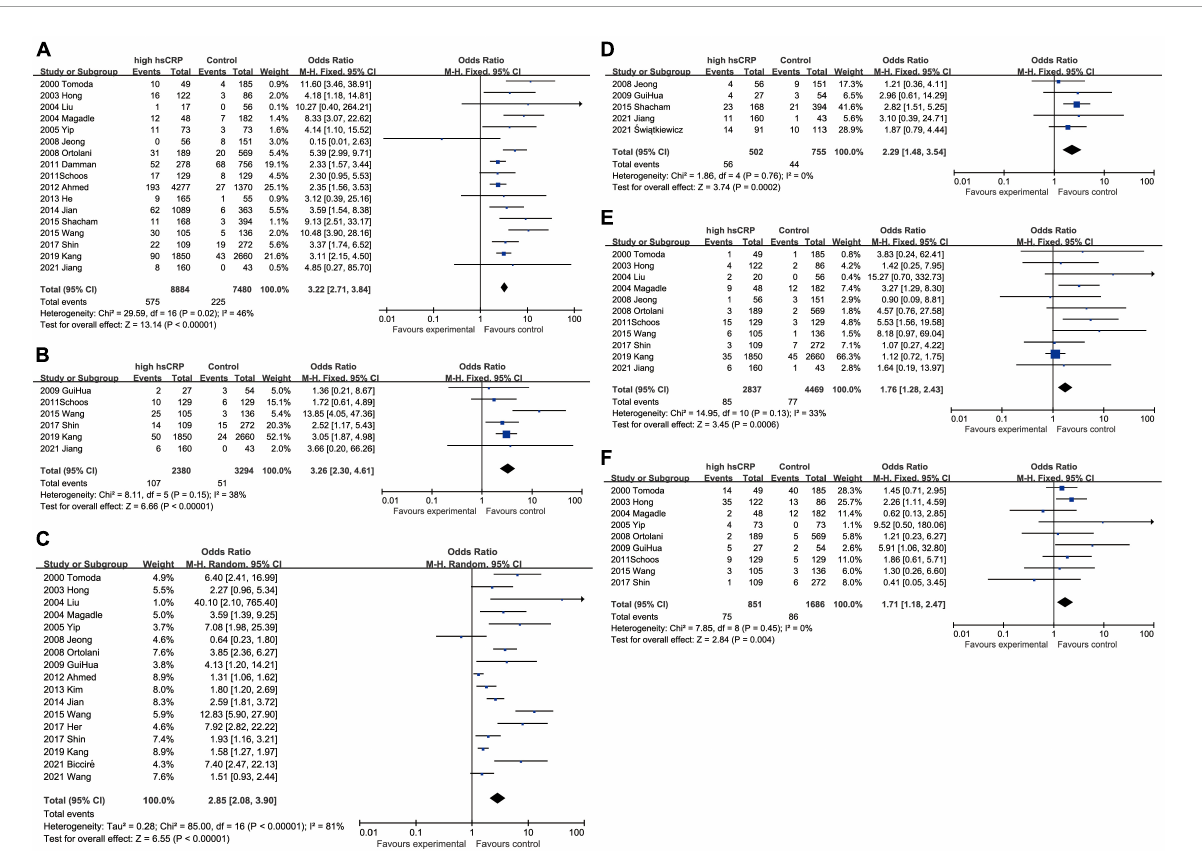
FIGURE2 Forest plots of studies assessing the association between elevated CRP and different outcomes among patients with AMI with PCI: (A) CRP and all-cause mortality; (B) CRP and cardiovascular mortality; (C) CRP and MACEs; (D) CRP and heart failure; (E) CRP and recurrent myocardial infarction; and (F) CRP and